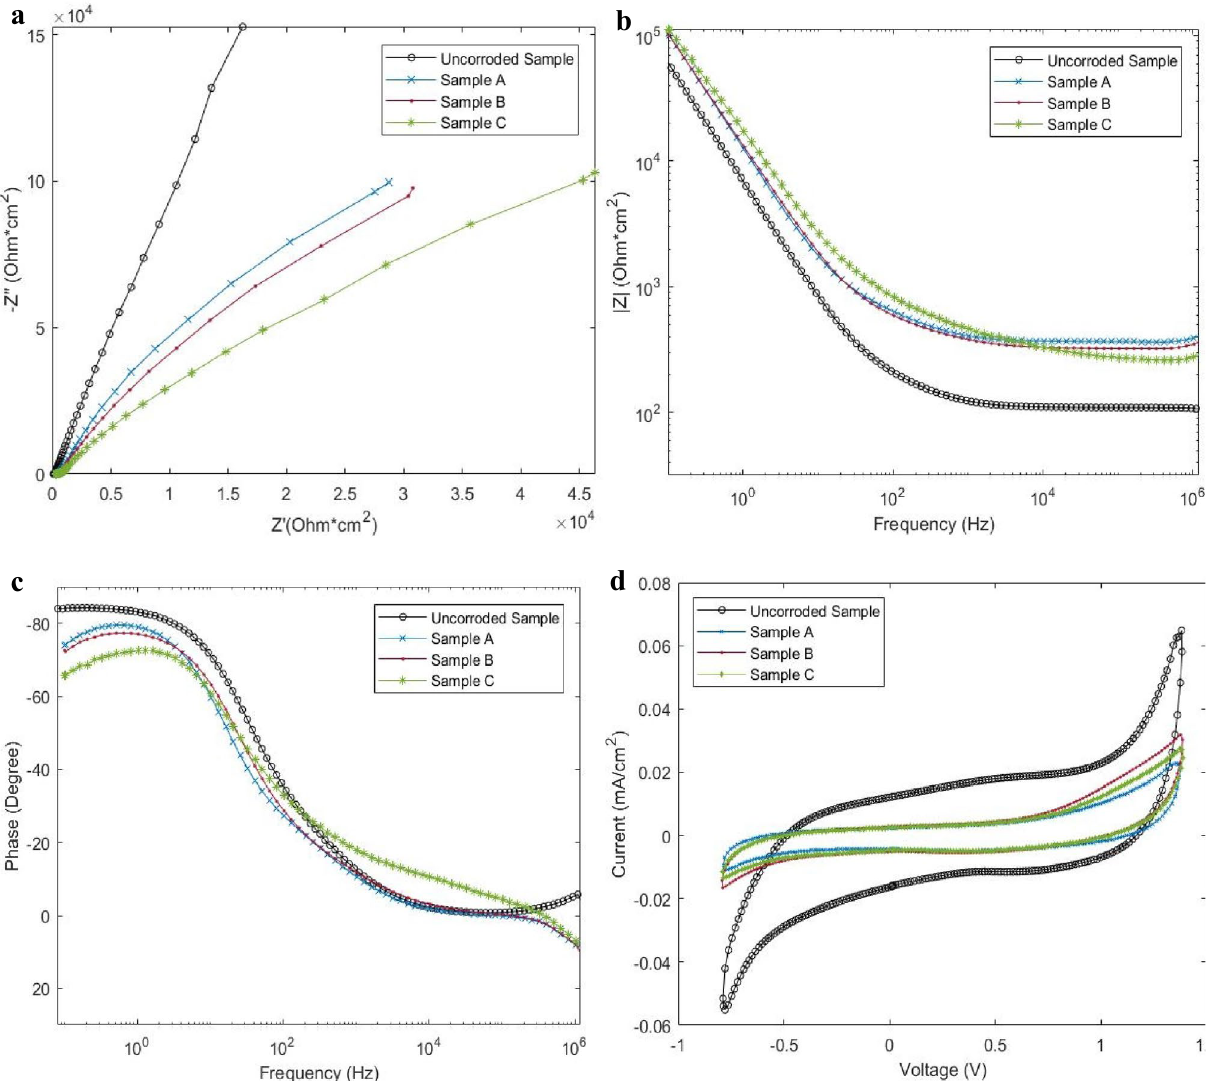
Figure 7. Area normalized EIS analysis and cyclic voltammetry analysis of corroded samples in fresh simulated synovial fluid. EIS analysis of the corroded samples in freshly prepared simulated synovial fluid. The uncorroded sample represents a freshly prepared, non-corroded test specimen. Sample A was shielded from electrical activity, Sample B was subjected to a 50 MHz, 200 mVpp sine wave, and Sample C was subjected to a 25 MHz, 200 mVpp square wave. ( a ) Comparison of positive real impedance (x-axis) and negative imaginary impedance (y-axis). ( b ) Total magnitude of impedance (y-axis) is plotted against frequency (x-axis). ( c ) Phase angle (y-axis) is plotted against frequency (x-axis). ( d ) Cyclic voltammetry analysis of samples at 100 mv/sec